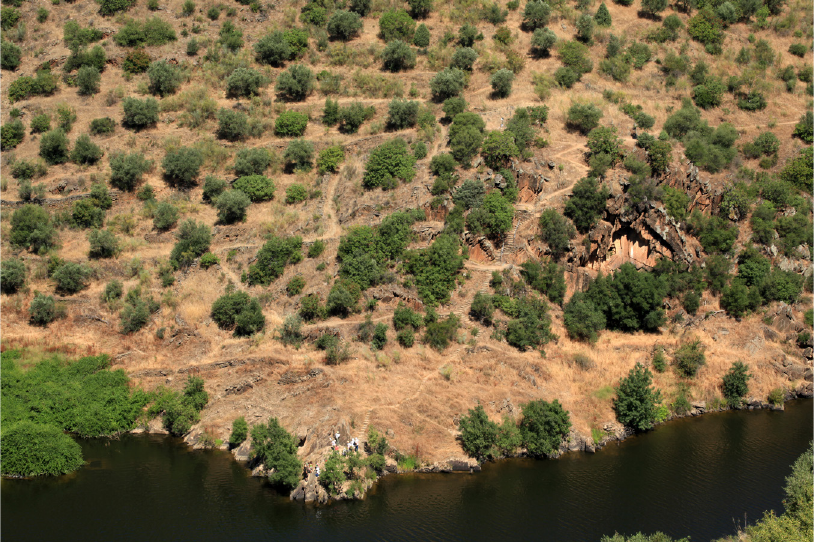
Figure 7. Partial view of the Canada do Inferno rock-art site, Côa Valley, Portugal. Note that some of the observable outcrops in the photo possess rock-art motifs (from the most ancient period at Côa or from more recent times) while others do not. Photo: Mário Reis.